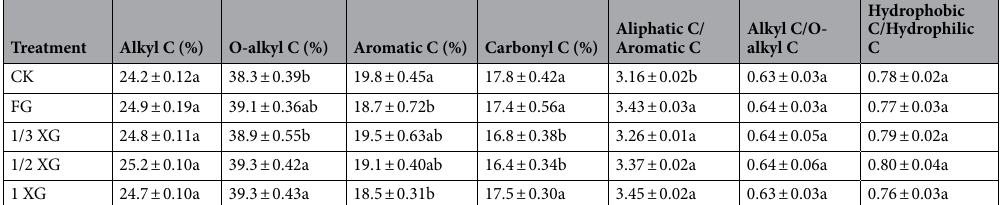
Table 1. Relative proportions of functional groups with different chemical shift intervals in the CPMAS 13 C- NMR spectra of black soil organic carbons from different straw return treatments. Aliphatic C/Aromatic C (Alkyl C + O-alkyl C)/Aromatic C, Hydrophobic C/Hydrophilic C (Alkyl C + Aromatic C)/(O-alkyl C + Carbonyl C), CK control (i.e., stubble remaining), FG full straw mulching return, 1 XG full rotary tillage return, 1/2 XG 1/2 rotary tillage return, 1/3 XG 1/3 rotary tillage return. Different letters in the same column represent significant difference ( p <